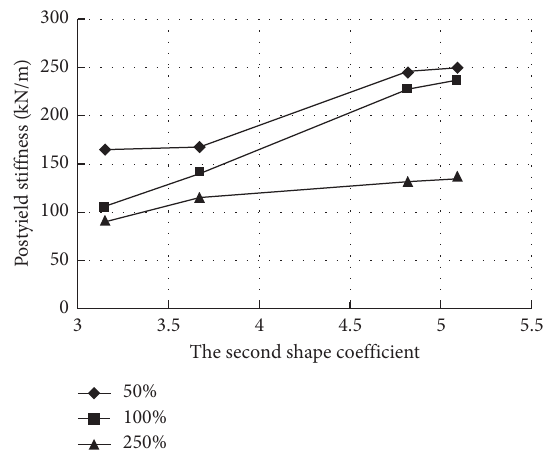
Figure 17: Relative equivalent horizontal stiffness with the second shape coefficient.